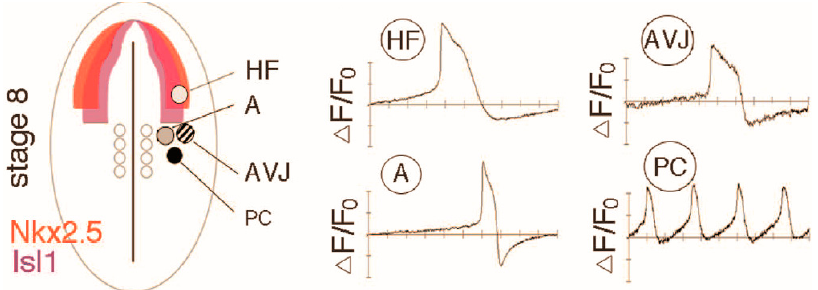
Figure 6. The origin of the pacemaking cells outside the primary and secondary heart fields [33]. Mesoderm cells were isolated from sites indicated by circles on the chicken embryo and cultured. Regions of Nkx2.5 and Isl1 expression are indicated in colors. HF = heart field, A = atrium, AVJ = atrioventricular junction, PC = pacemaking cells. Representative optical tracings obtained by OM of membrane potentials from regions indicated in the diagram after 72 h of culture.